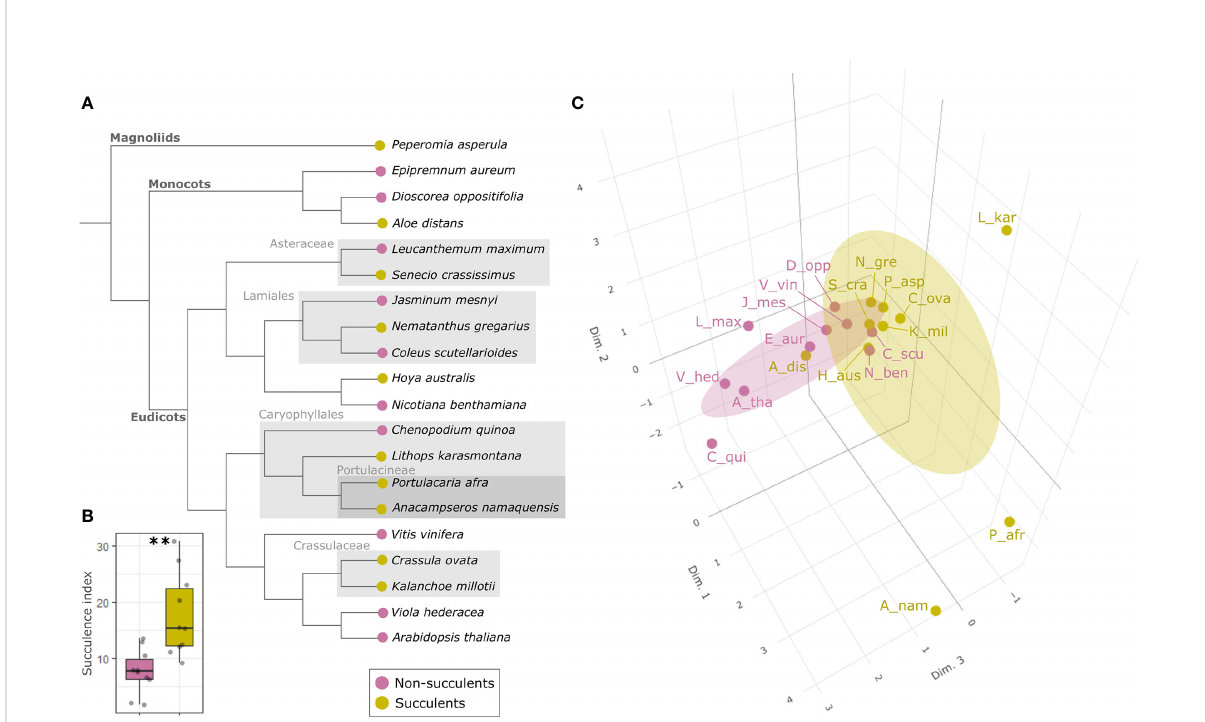
FIGURE 2 The succulent glycome: succulents and non-succulents occupy different phenotypic spaces in terms of glycomic pro fi les. (A) Cladogram representing the phylogenetic relationship (according to Baker et al., 2022) among the 20 species included in this study; some major clades are indicated in grey for clarity. (B) Boxplot of succulence index (SI) values for all the species; the two groups differ signi fi cantly (** p < 0.01) according to Welch ’ s t -test. (C) 3D score plot of the fi rst three MFA dimensions (17%, 12.1% and 10.8% of total variance respectively) of glycomic data from 10 leaf succulents and 10 non-succulents (see Table S1 for abbreviations), with concentration ellipsoids for each group. Succulents and non-succulents occupy distinct phenotypic spaces, particularly along dimension